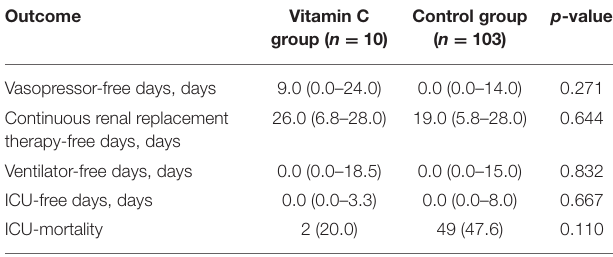
TABLE 2 | Outcomes of patients included in the observational study. Control group Outcome Vitamin C group ( n = 10) ( n = 103)